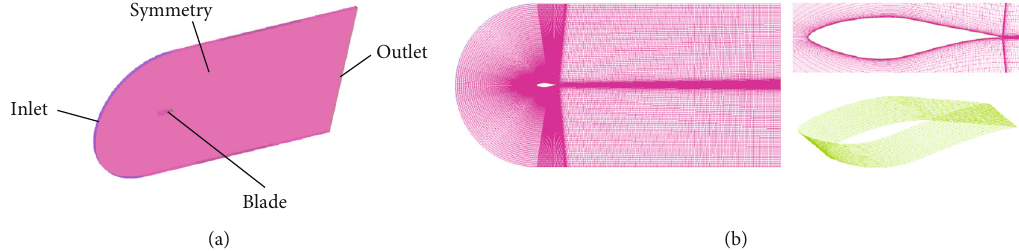
Figure 17: Mesh generation of S809: (a) calculated three-dimensional domain and (b) mesh.